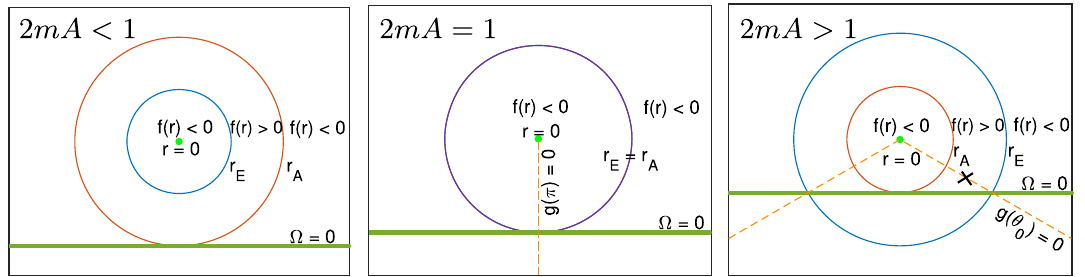
values of θ such that g (θ) = 0, and the solid circles are the event (blue) and acceleration (red) horizons at r E and r A , respectively. Note that only positive values of r are considered, and recall that in the north hemisphere the conformal infinity is reached for negative values of